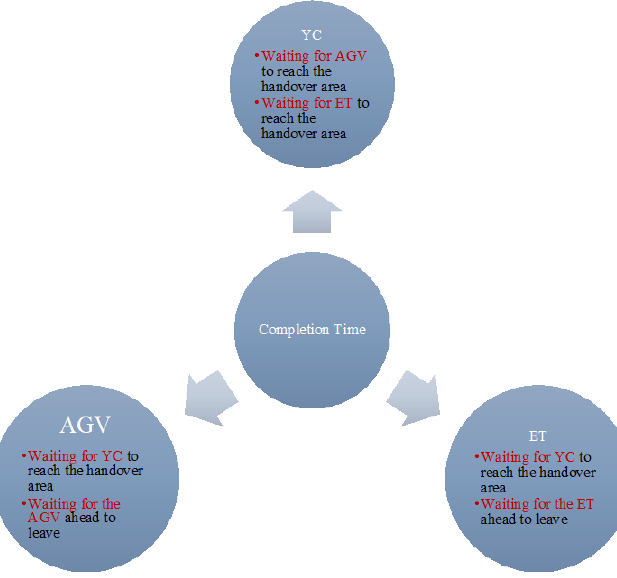
Figure 5. Constraint relationship of YC, AGV and ET.